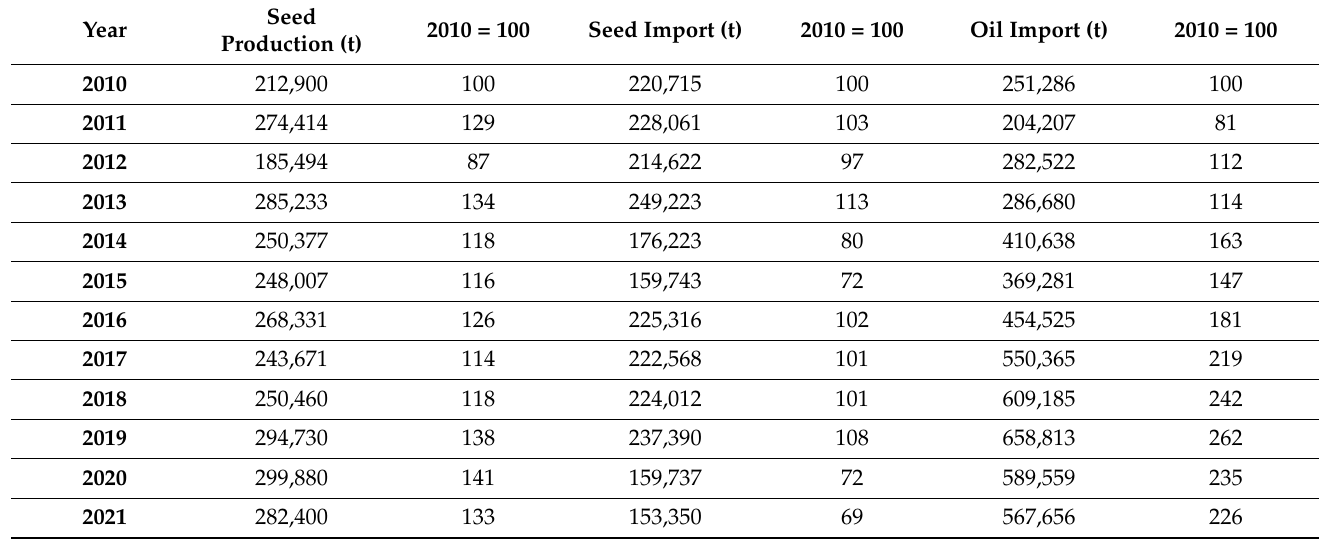
Table 2. Italian sunflower production and import (2010–2021).